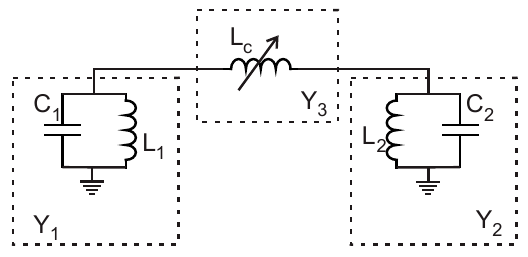
Figure 2. Simplified equivalent circuit model.